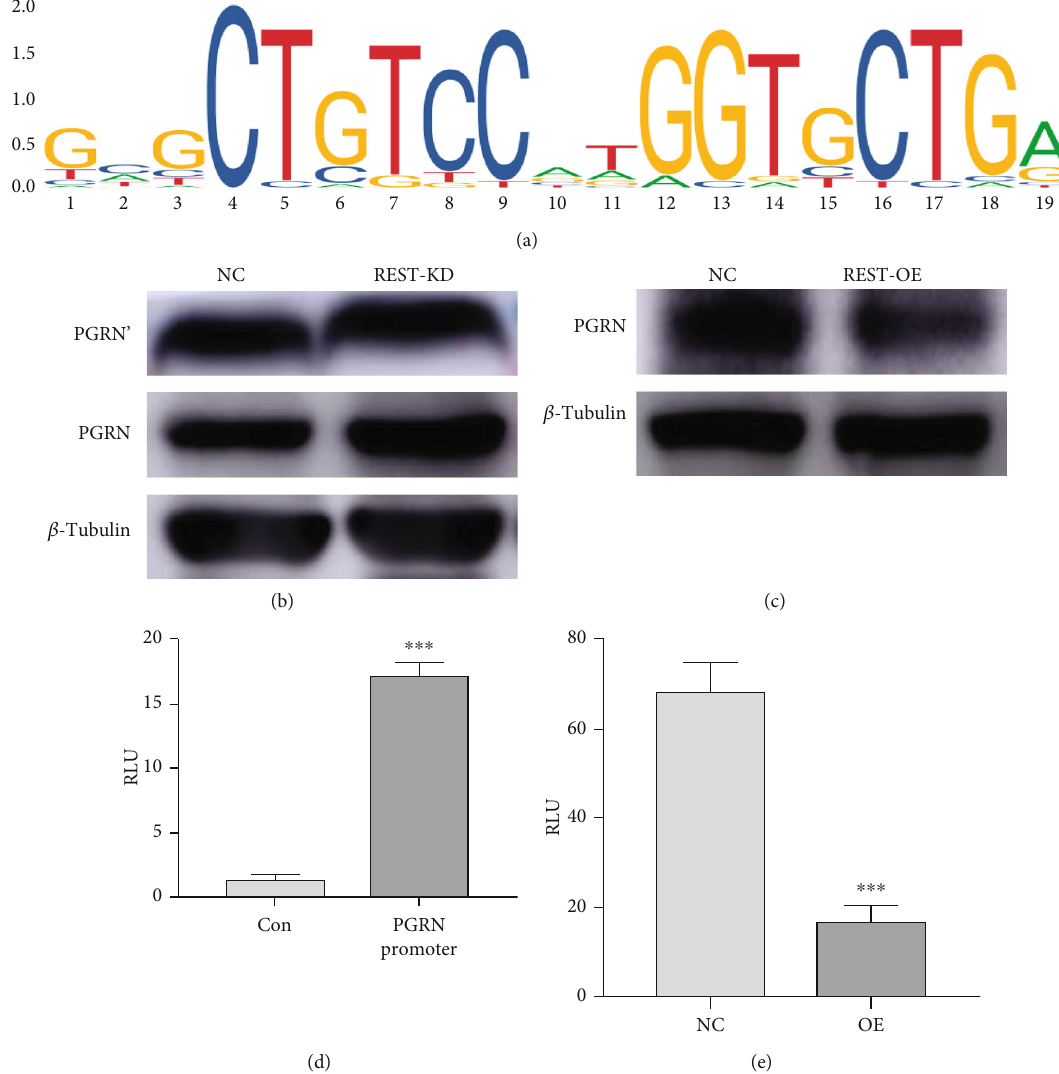
Figure 5: REST repress PGRN promoter activity. (a) Putative REST binding sequences in upstream of the PGRN gene coding sequences were predicted from JASPAR database. (b) Knocking down of REST induced PGRN expression and secretion. (c) Overexpression of REST repressed PGRN expression. (d, e) overexpression of REST repressed PGRN promoter transcriptional activity. KD: knock down; OE: